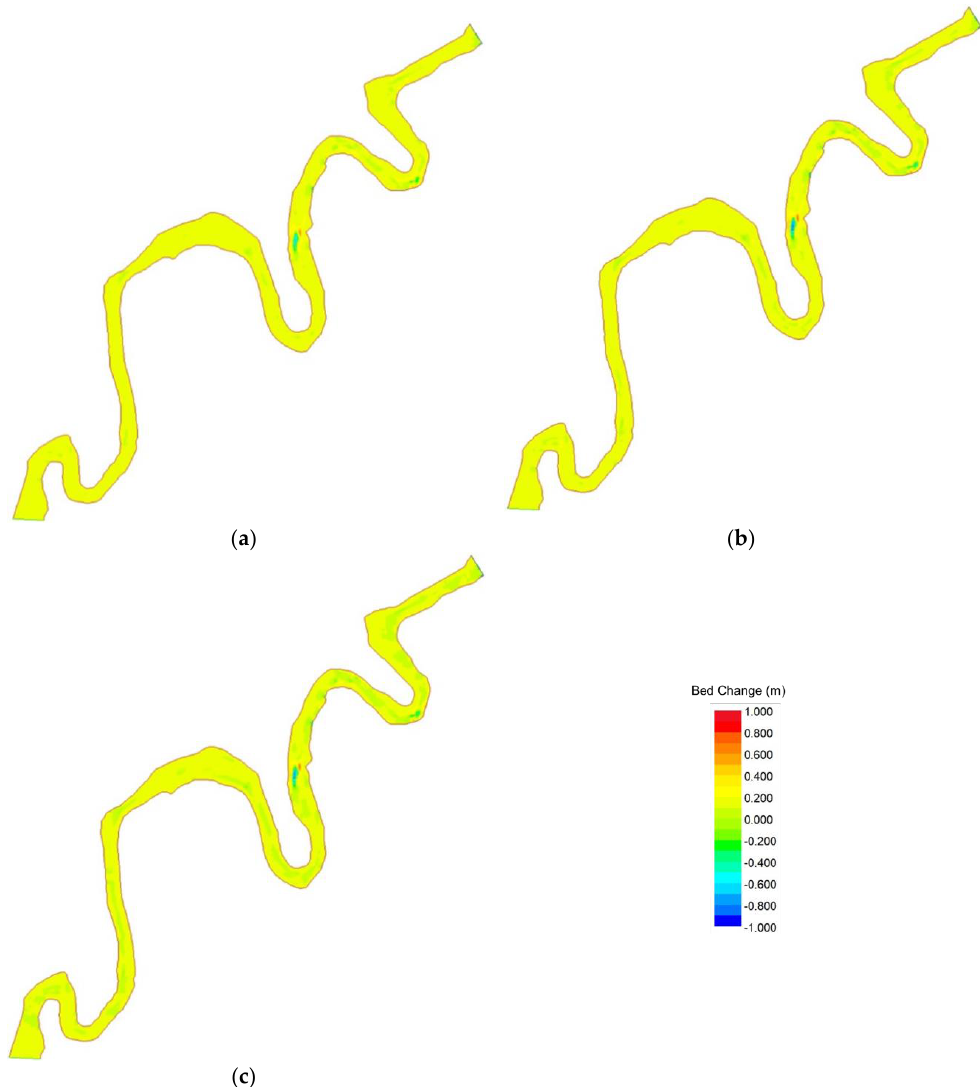
Figure 11. The bed elevation change ( a ) after first flood, ( b ) after the third flood, and ( c ) after the fifth flood.